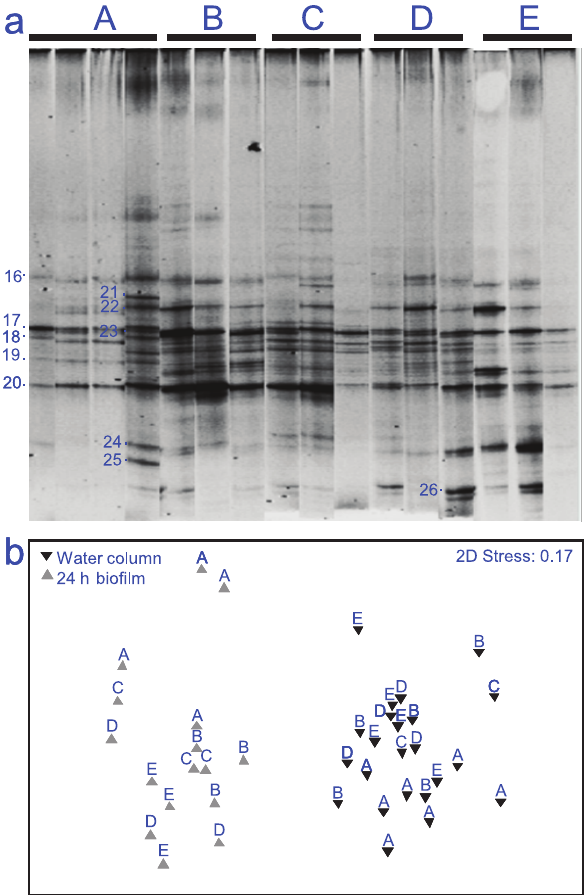
Figure 7. Variation in 16S rRNA gene fingerprints between sample types (spatial samples A–E) for summer season (March 2009); (a) Composite DGGE image standardised for gel-to-gel comparison using BioNumerics, (b) Multidimensional scaling (MDS) plot based on relative band intensity from composite DGGE profile of the